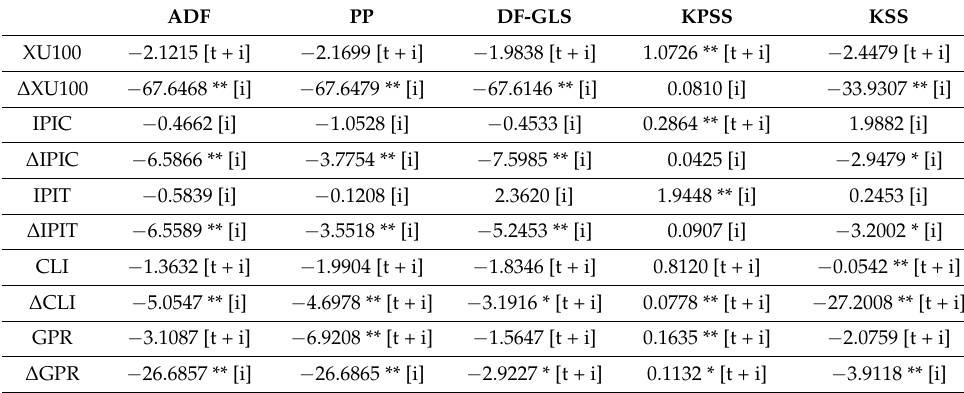
Table 3. Linear and Nonlinear Unit Root and Stationarity